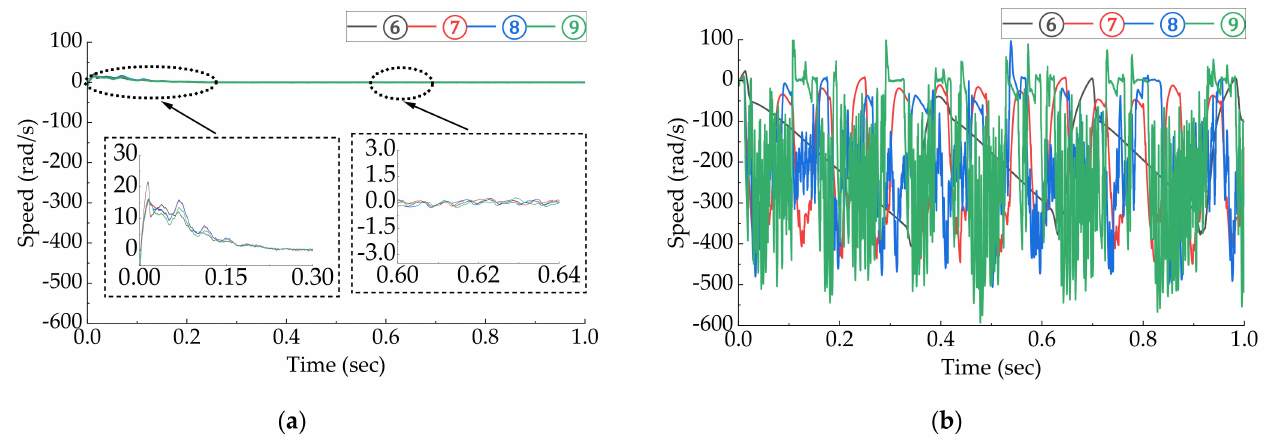
Figure 5. ( a ) When the Q value is 6 (cid:13) – 9 (cid:13) , the speed is estimated by the PAEKF; ( b ) when the Q value is 6 (cid:13) – 9 (cid:13) , the speed is estimated by the EKF.